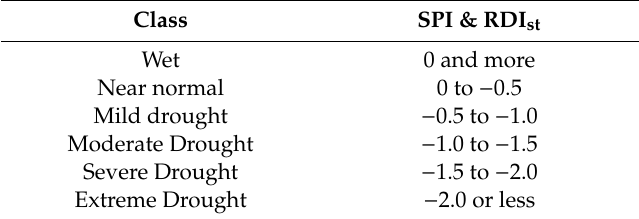
Table 1. The classification of drought by using SPI and RDI st . Class SPI & RDI